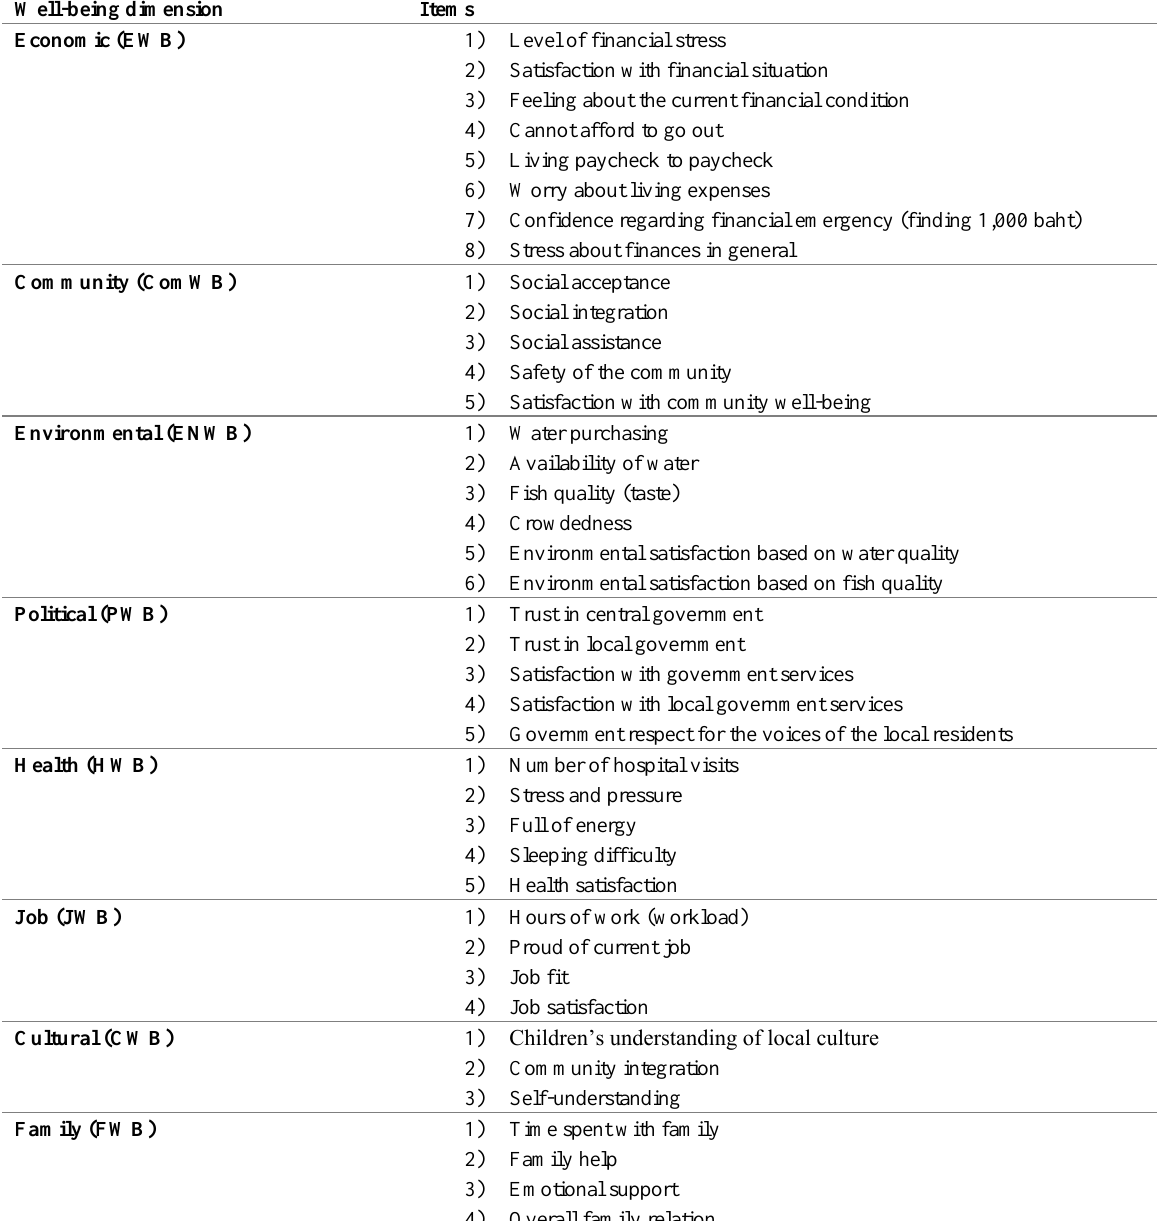
Table 2: Well-being